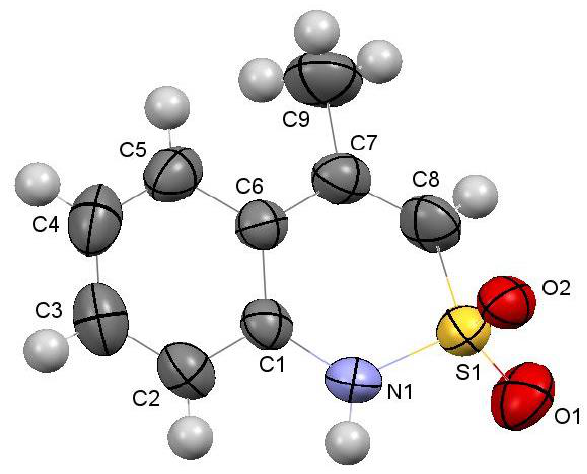
Figure 8. The molecular structure of benzothiazine 7 with atoms represented by thermal vibration ellipsoids of 50% probability.